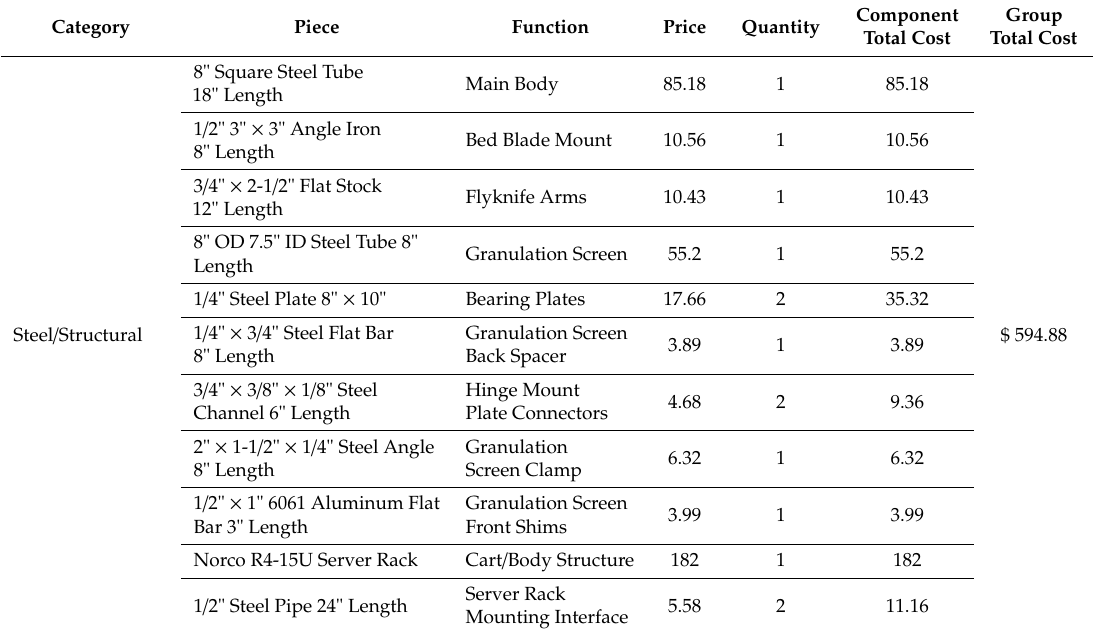
Figure 14. Cost breakdown of the bill of materials for the open source granulator. Table 2. Costs of all the components and numbers and sub-systems in the bill of materials for the open source granulator.